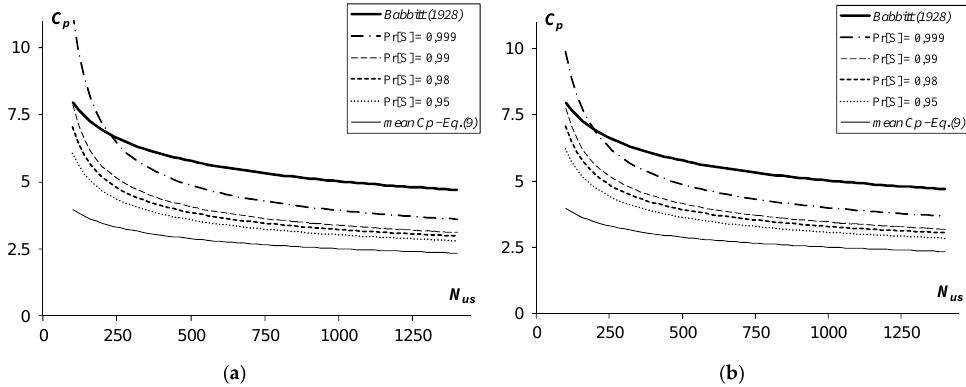
Figure 4. Peak Demand Coefficient versus user number for predefined success probability, and for CDFs: Log ‐ Logistic Distribution ( a ); Gumbel Distribution ( b )